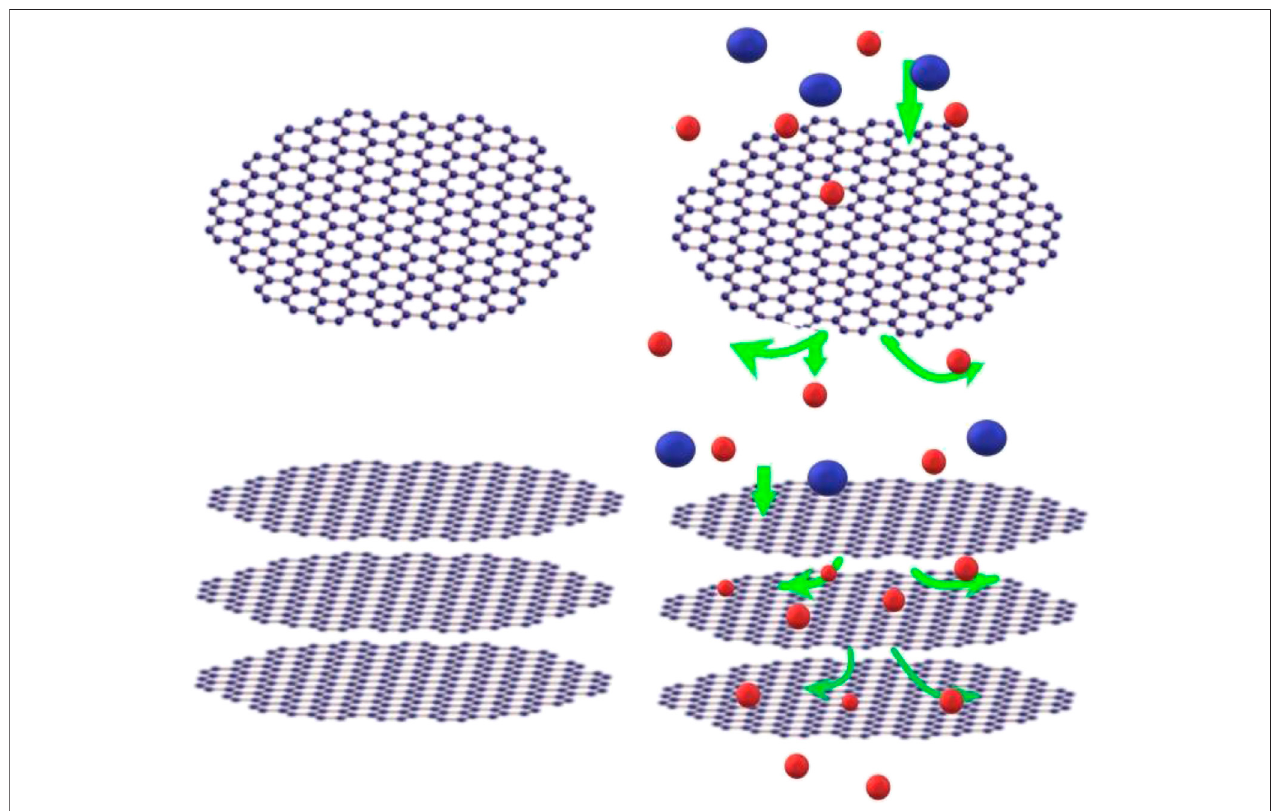
FIGURE 3 | Schematic diagrams of single-layer and multi-layer graphenes.